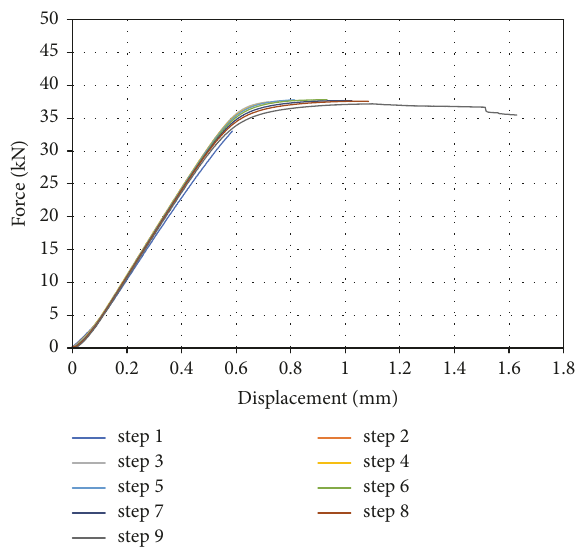
Figure 10: Force-displacement curves for the central